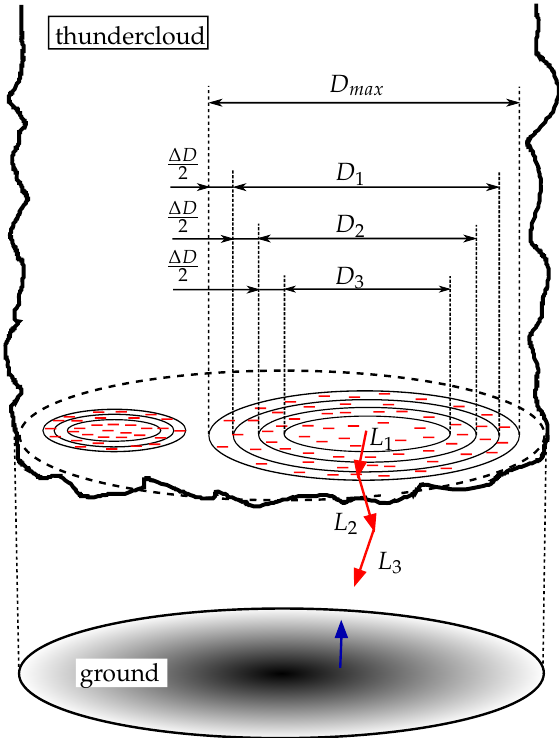
Figure 2. Stepped leader progression in different sections (stages). Reproduced/Adapted with permission from